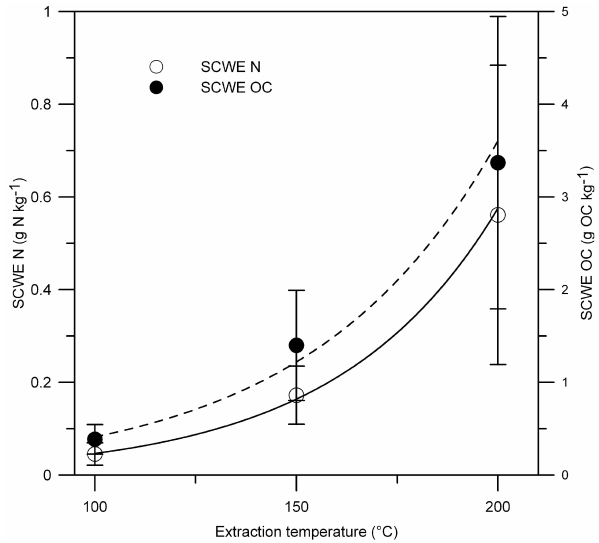
Fig. 4. Release of N and OC by subcritical water extraction in func- tion of the extraction temperature. Symbols show means with stan- dard deviations in error bars of 25 paddy soils, line graphs show exponential models fitted to the